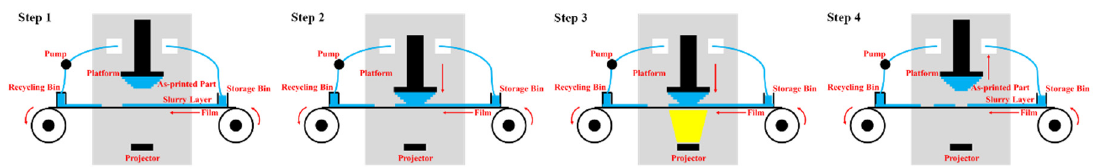
Figure 1. The illustration of the printing process (Step 1: slurry layer is transported, Step 2: platform descends slowly, Step 3: photocure, Step 4: platform rises).